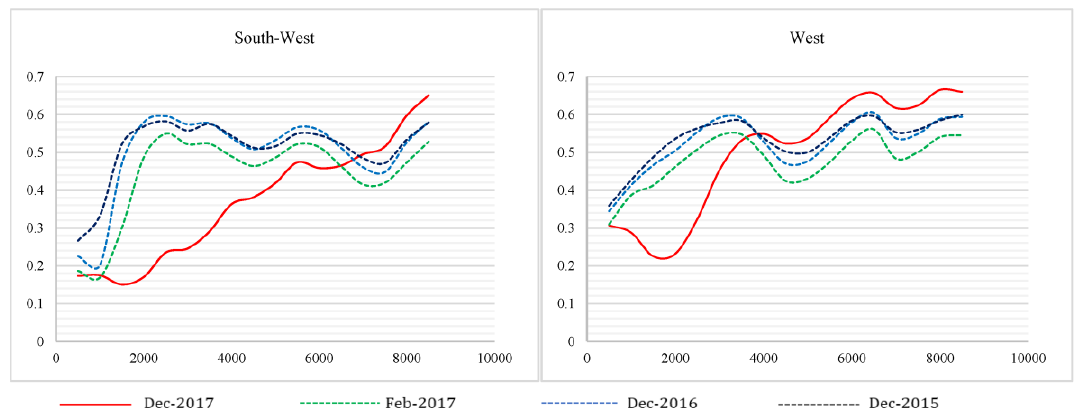
Figure 6. NDVI in the two most affected directions (i.e., Southwest and West) in the 10 km buffer around Kutupalong and surrounding refugee camp area from 2015 to 2017. The Y-axis represents NDVI ranging between +1 and −1. The X-axis represents the distance of each buffer (500 m increments). Higher NDVI values indicate healthy, green vegetation while lower values correspond with stressed, depleted vegetation or barren land. The above graph indicates that vegetation greenness/health was persistent in the pre-influx period (i.e., pre-august 2017); however, vegetation health and biomass declined significantly in the post-influx period in the two most affected directions of Southwest and West of the Kutupalong–Balukhali camps.